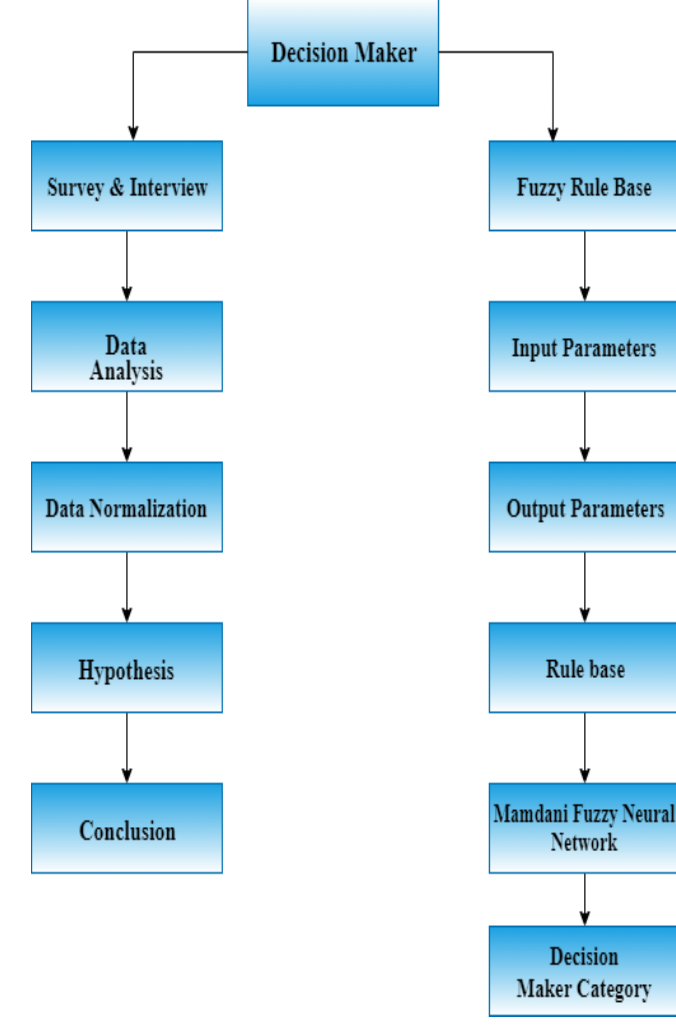
Figure 6. Flow chart of the proposed architecture